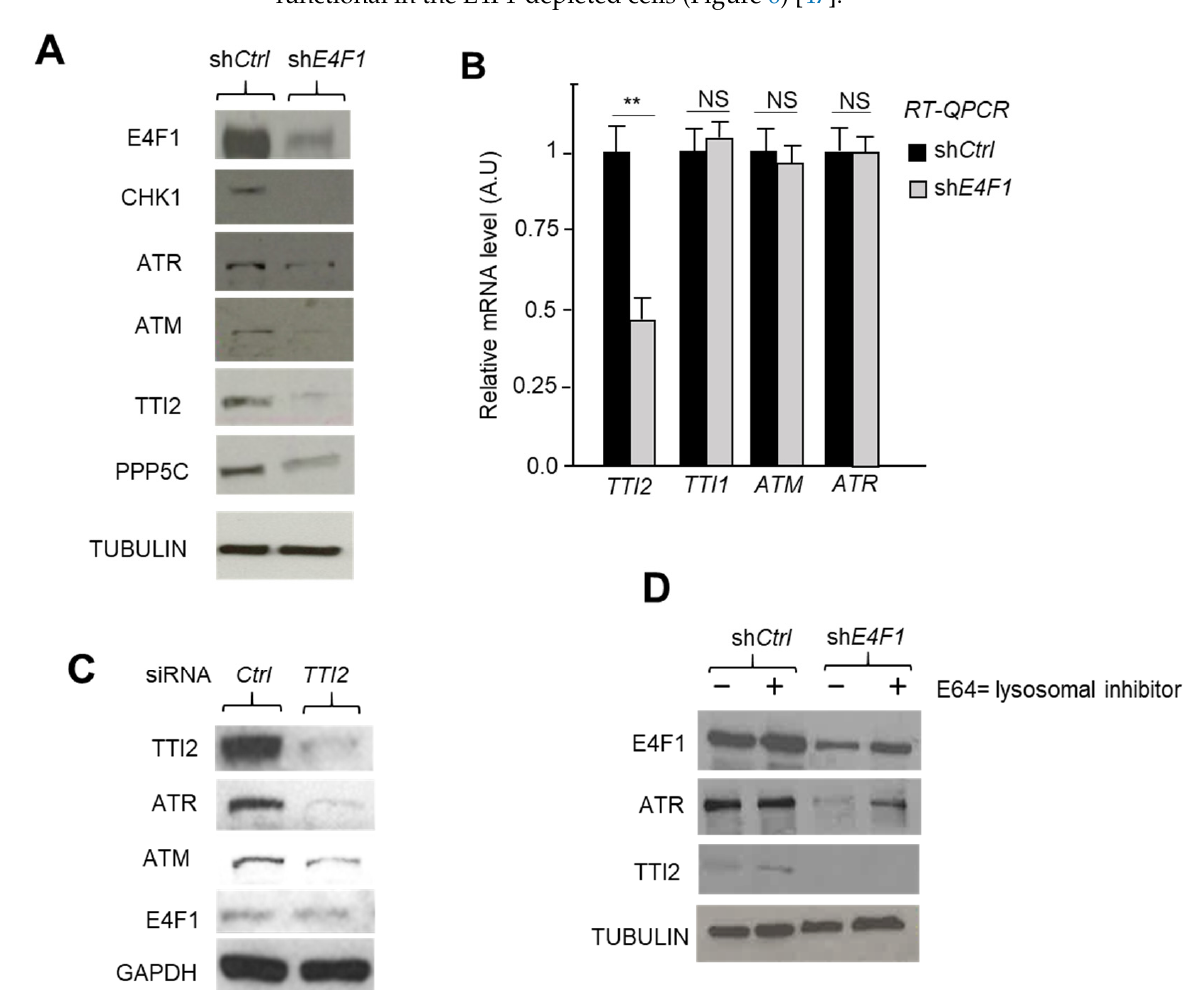
Figure 4. The transcriptional control exercised by E4F1 on the TTT complex component TTI2, strongly impacts on ATM and ATR protein levels in the TNBC cell line, SUM159. ( A )—E4F1 depletion impacts on TTI2, ATM and ATR protein levels. Immunoblot analysis of indicated proteins in total extracts prepared from SUM159 cells treated with either sh Ctrl or sh E4F1 . Extracts were prepared 4 days after cell infection with lentiviral vectors expressing shRNAs; ( B )—E4F1 depletion impacts on TTI2 mRNA level, but not on ATM and ATR mRNA levels, nor on the mRNA level of TTI1, another component of the TTT complex. Measured by RT-qPCR, 5 days after cell infection with lentiviral vectors expressing either sh Ctrl or sh E4F1 . Data are means ± SD, n = 3 independent experiments. ** p < 0.01, as determined by a one way ANOVA test performed on GraphPad Prism; ( C )—siRNA-mediated depletion of TTI2 impacts on ATR and ATM protein levels in SUM159. Immunoblot analysis of indicated proteins in total extracts prepared from SUM159 cells treated for 48 h with either a control siRNA (siCtrl) or an siRNA directed against human TTI2 mRNA; ( D )—Immunoblot analysis of indicated proteins in total extracts prepared from SUM159 cells treated with either sh Ctrl or sh E4F1 and with the lysosomal inhibitor E64 (10 μ M).